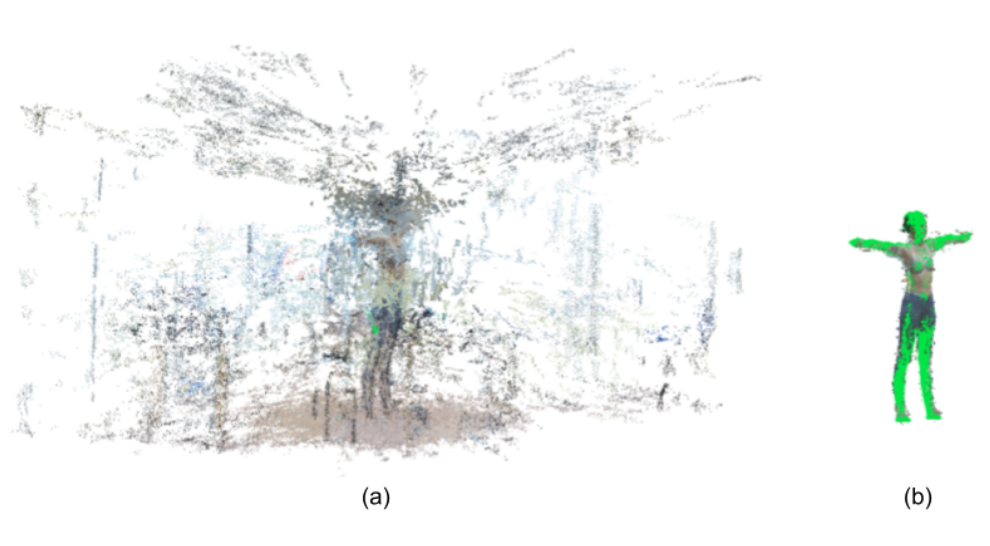
Figure 6. Automatic registration between ( a ) SfM-based point cloud from raw video and ( b ) BRemNet - segmented point cloud with LiDAR-based mesh (green).